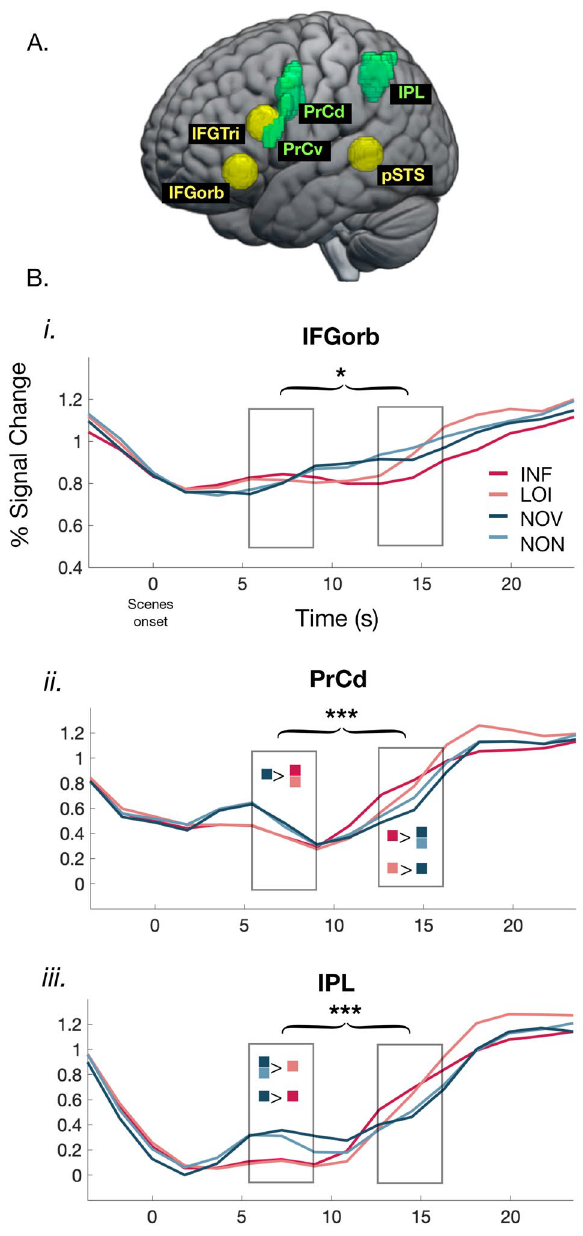
Figure 3. Temporal course of brain activations in Regions of interest (ROIs). ( A ) ROIs associated to syntactic processing, from (14) (IFGorb- inferior frontal gyrus orbitalis; IFGtri- inferior frontal gyrus triangularis; pSTS- posterior Superior Temporal Sulcus, in yellow), and to verbal reasoning from (5) ( PrCd —precentral dorsal, PrCv —precentral ventral—colored in green; IPL, inferior parietal lobule). ( B ) Signal changes in ROIs with interactions between Phase and Condition (see Supplementary Materials for all the ROIs). Graphs represent mean coefficients per ROI computed from a FIR model; x-axis extends from Trial onset to the Response phase included (total length: 28 s). Rectangular boxes indicate the Scooping and Object Out phases. Colored squares indicate differences between Conditions, and asterisks spanning across phases interactions (Bonferroni corrected, N = 6), resulting by separate ANOVAs for each